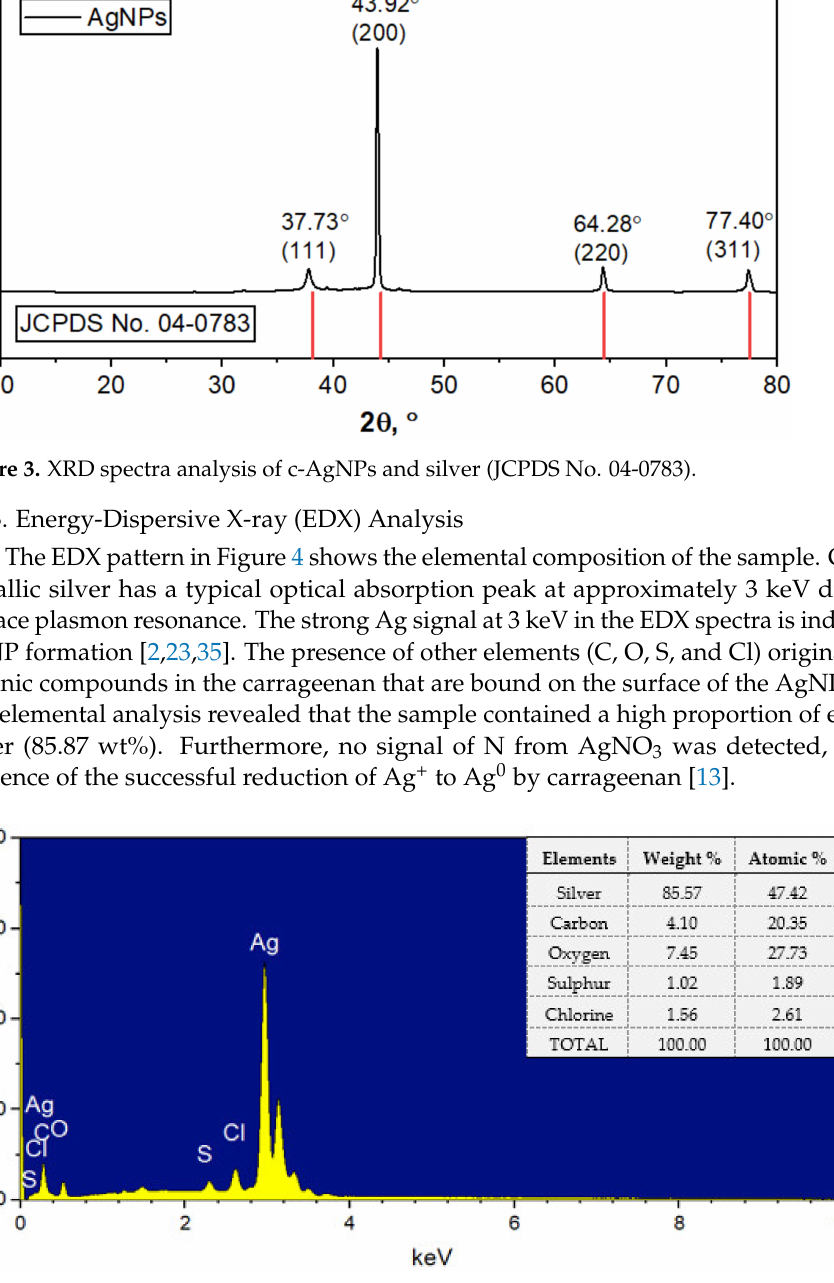
Figure 4. EDX spectra of c-AgNPs and the corresponding elemental